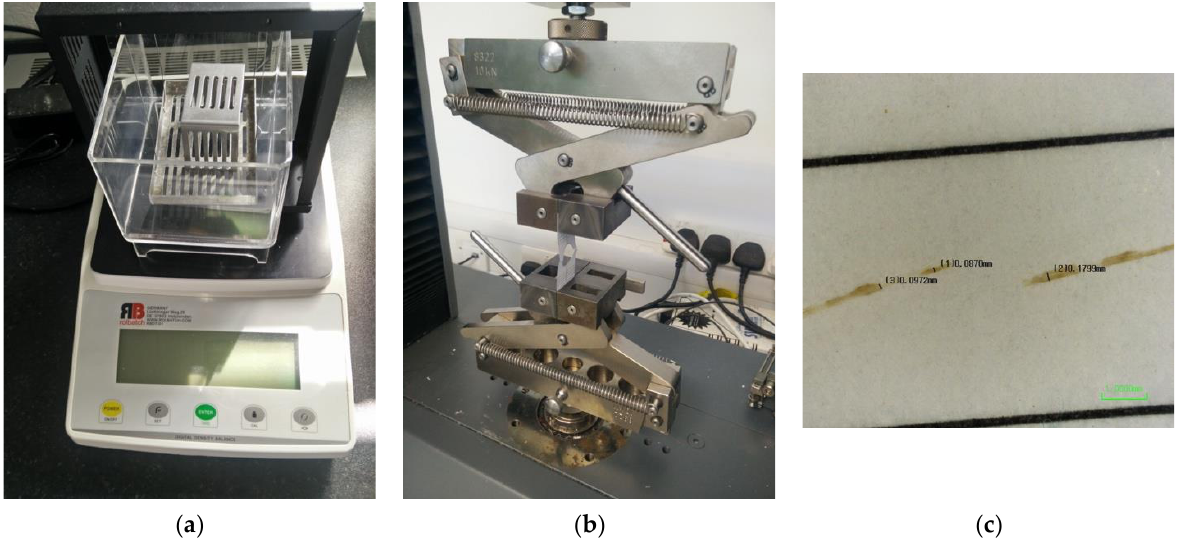
Figure 2. ( a ) Digital balance ( b ) specimen in between grips during the tensile test ( c ) diameter of fibres measured after rupture. Table 3. Mechanical and physical properties of natural fibres [26].